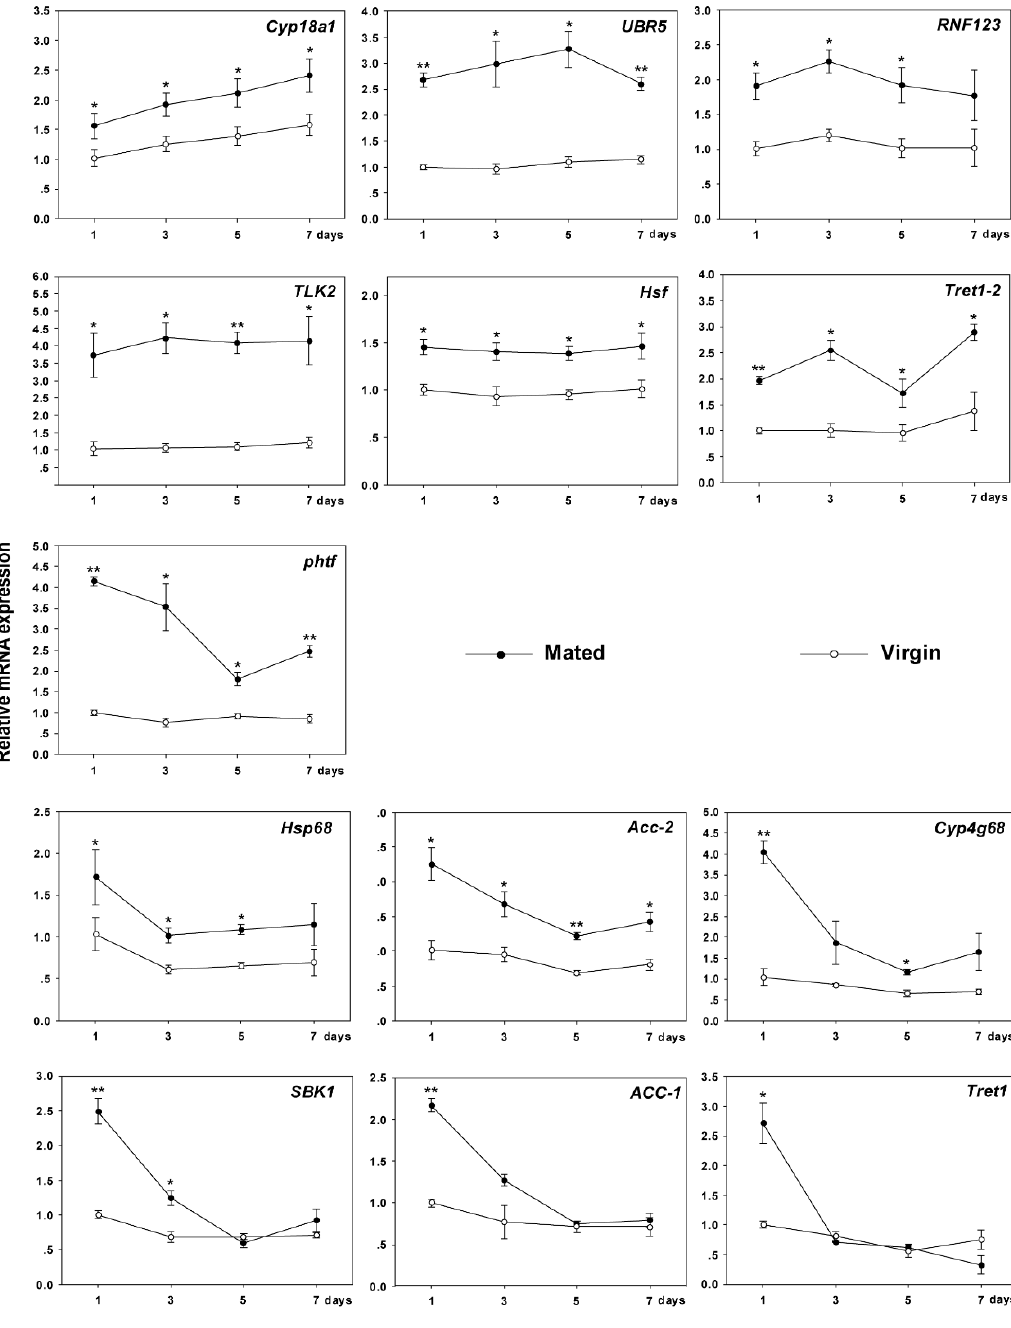
Figure 5. Gene expression profiles of selected mating-related DEGs at different time points for mated and virgin B. tabaci females, as determined by RT-qPCR. Mean expression levels (±SEM) of genes in virgin females. Asterisks indicate significant differences between the expression profiles of mated and virgin females. * p < 0.05; ** p < 0.01.